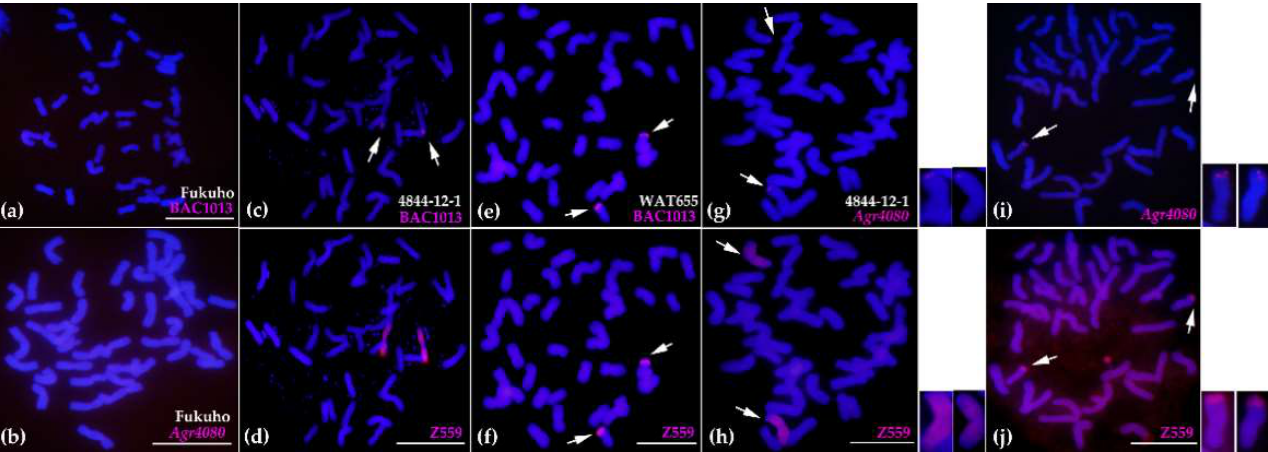
Figure 3. The FISH and GISH patterns of common wheat “Fukuho”, the substitution line 4844-12-1, and the translocation line WAT655 using the DNA of the BAC clone “BAC1013”, the gene Agr4080 , and A . cristatum “Z559” as the probes. ( a , b ) The FISH patterns of common wheat “Fukuho” using the probes BAC1013 and Agr4080 . ( c , e ) The FISH patterns of the substitution line 4844-12-1 and the translocation line WAT655 using the probe BAC1013. ( g , i ) The FISH patterns of the substitution line 4844-12-1 and the translocation line WAT655 using the probe Agr4080 . ( d – j ) The GISH patterns of the substitution line 4844-12-1 and the translocation line WAT655 using the DNA of A . cristatum “Z559” as the probe. A . cristatum 6P chromosomal segments were in red, while wheat chromosomes were in blue strained by 4′,6-diamidino-2-phenylindole (DAPI). The white arrows indicated the A . cristatum chromatin in the wheat background. (scale bar = 10 µm).